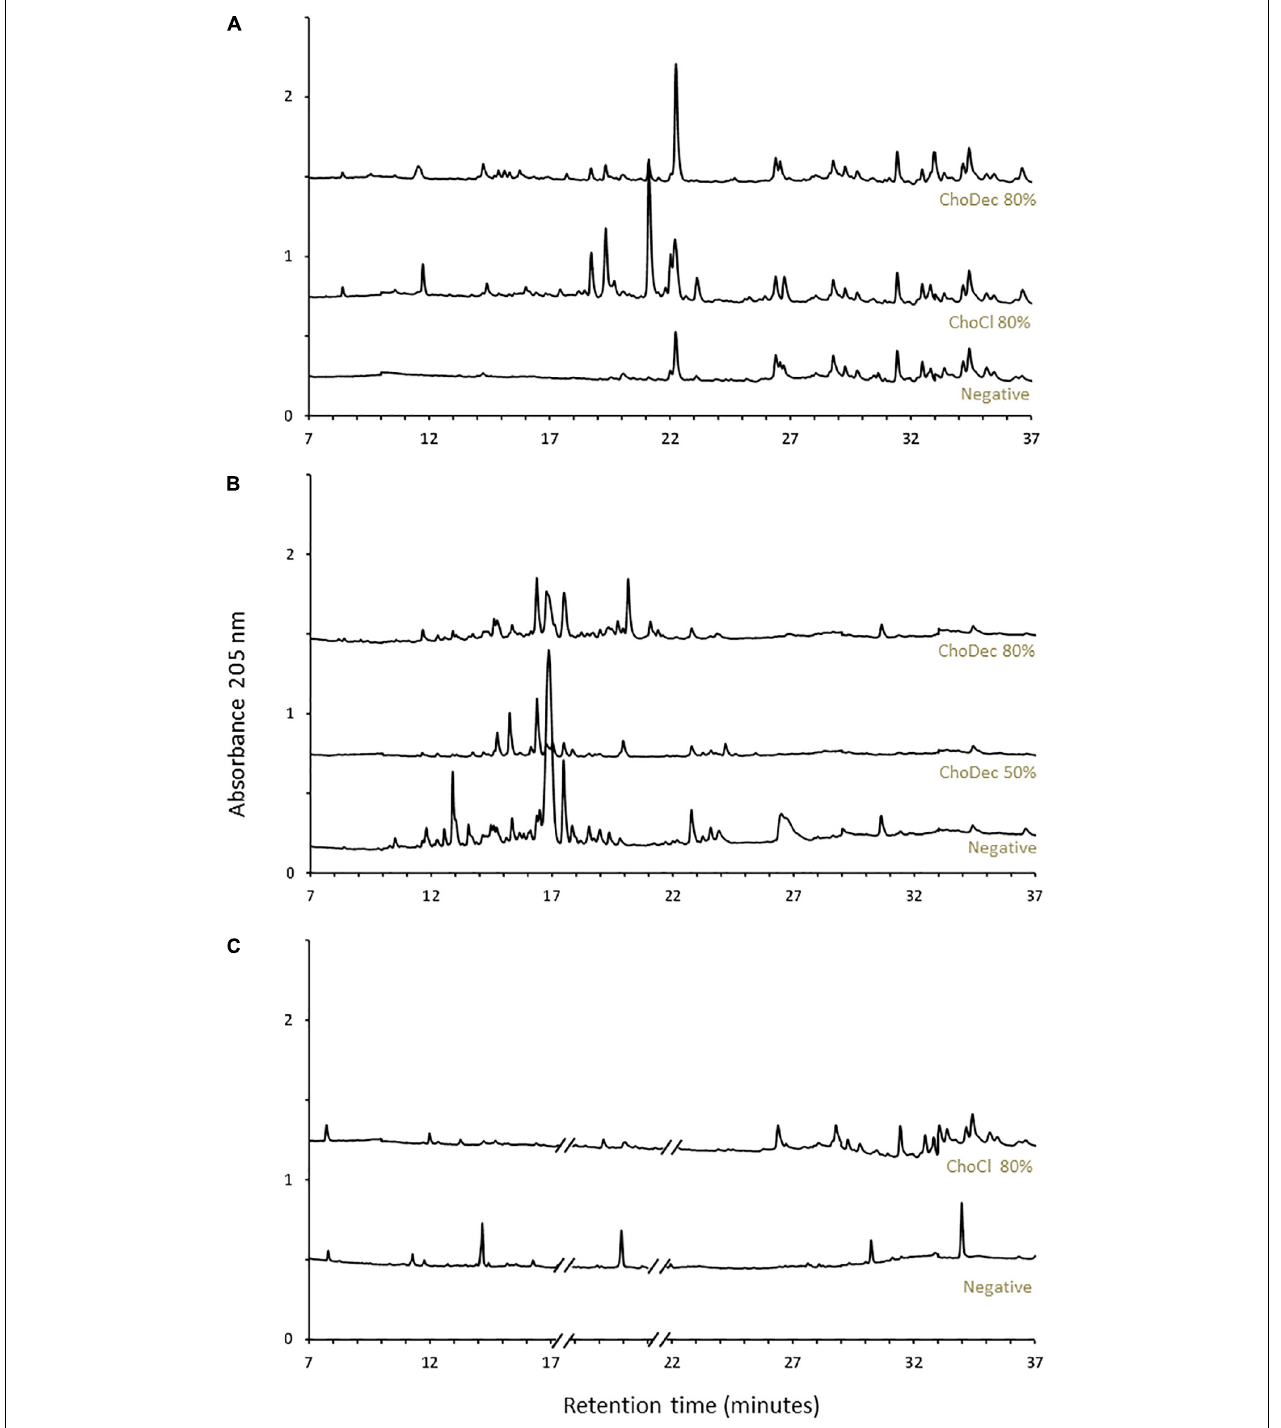
FIGURE 1 | Ionic liquid supplements triggered a metabolic shift in the fungal cultures. Chromatographic analyses of the metabolic footprint of A. nidulans (A) , A. fumigatus (B) , and N. crassa (C) crude extracts. Crude extracts are from cultures grown for 10 days in either choline chloride (ChoCl) or choline decanoate (ChoDec) supplemented media, at 50 or 80% of the MIC, and from cultures without ionic liquid supplementation (i.e., negative controls). Truncated parts of the chromatogram from N. crassa cultures (C) correspond to the elution of protease inhibitors. The y -axis scale represents the base peak intensity, where units are